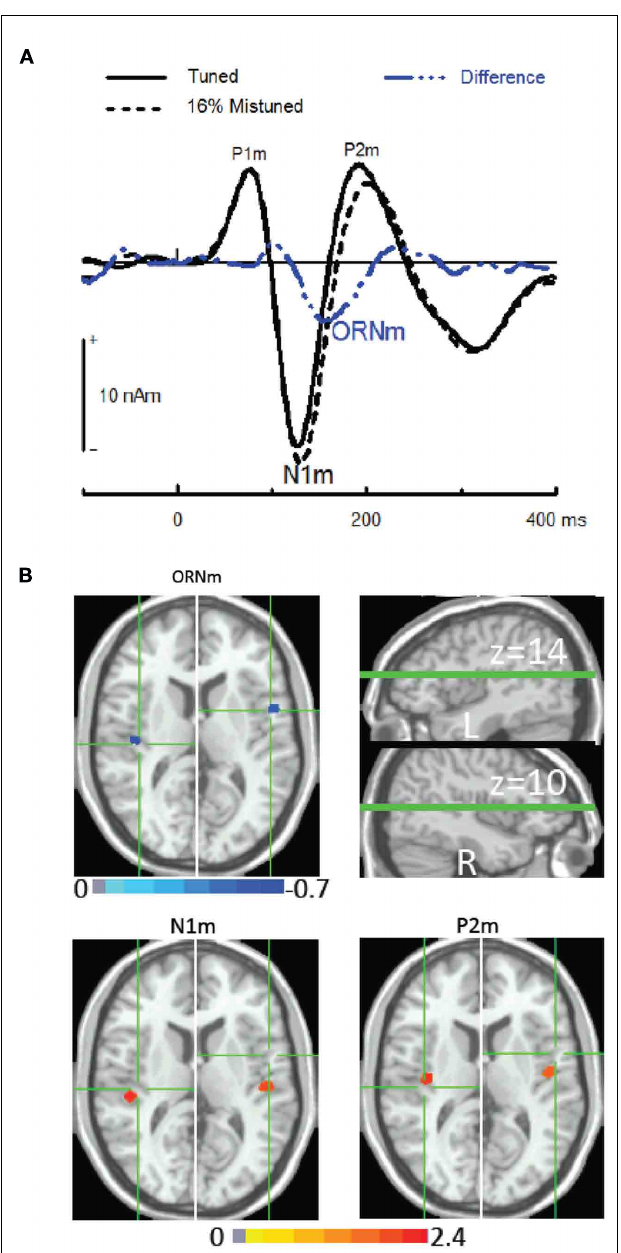
FIGURE 3 |A neural marker of concurrent sound segregation based on harmonicity. (A) Neuromagnetic activity elicited by harmonic complexes that had all harmonics in tune or the third harmonic mistuned by 16% of its original value.The magnetic version of the ORN (ORNm) is isolated in the difference wave between responses elicited by the tuned and mistuned stimuli.The group mean responses are from 12 young adults. (B) Source modeling using the beamforming technique called event-related synthetic aperture magnetometry (ER-SAM).The activation maps (group image results) are overlaid on a brain image conforming toTalairach space. Green cross hairs highlight the location of the peak maxima for the ORNm sources (blue) derived from subtracting the ER-SAM results for the 0% mistuned stimulus from that of the 16% mistuned stimulus. For comparison, ER-SAM source maps at the time interval of the peak N1m and P2m responses (red) are plotted at the same ORNm axial ( z -plane)